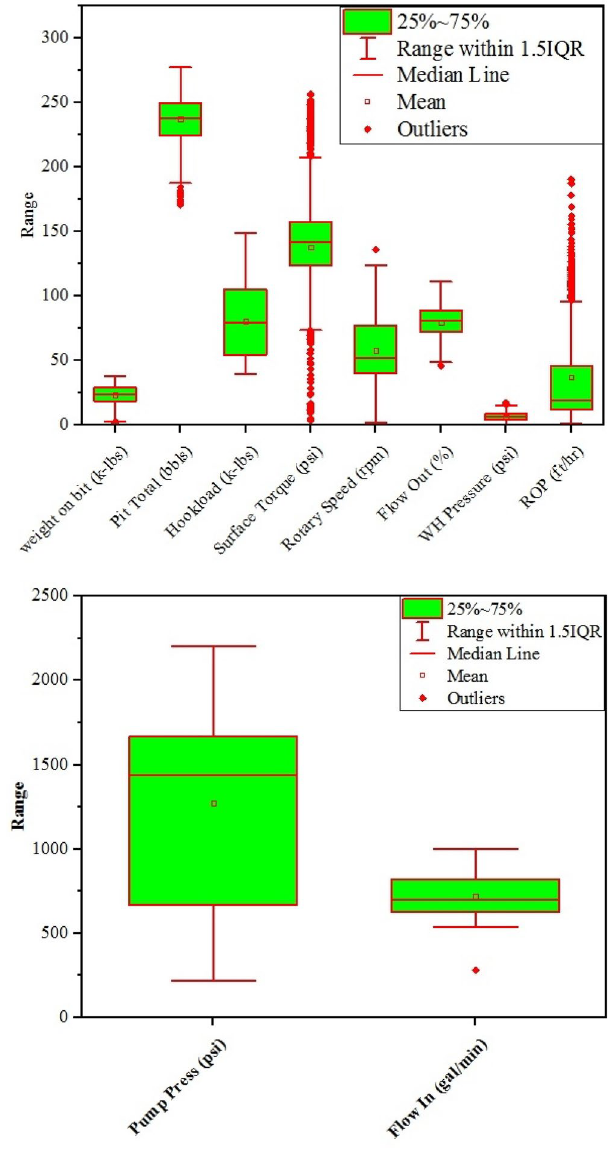
Figure 7. Box plot of inputs and output